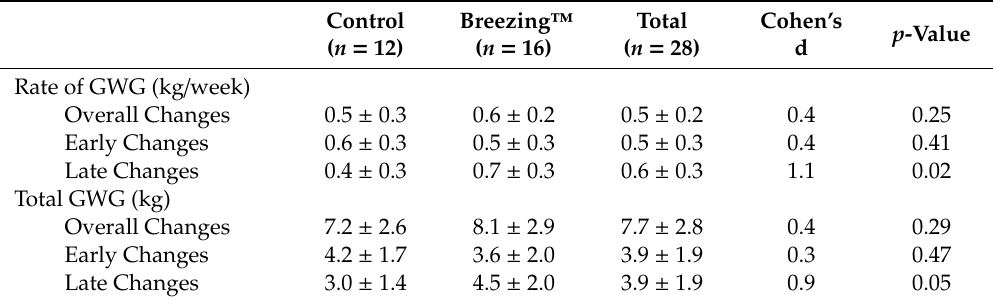
Table 2. Mean ± SD Group Di ff erences in the Rate of and Total Gestational Weight Gain (GWG) Among Study